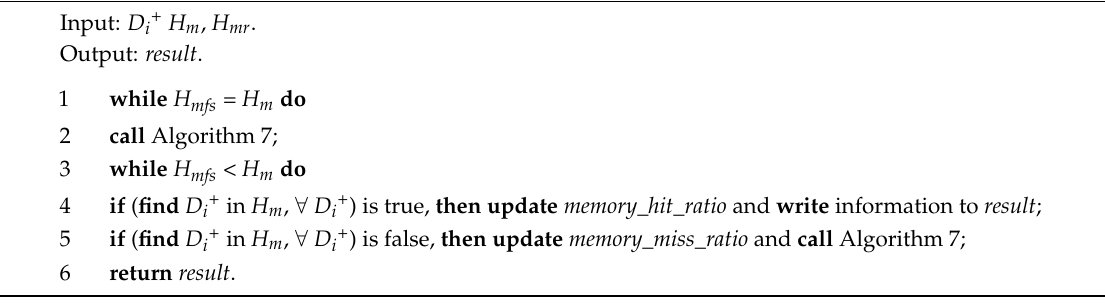
Algorithm 6. Visit current data (hit or miss) in the memory cache